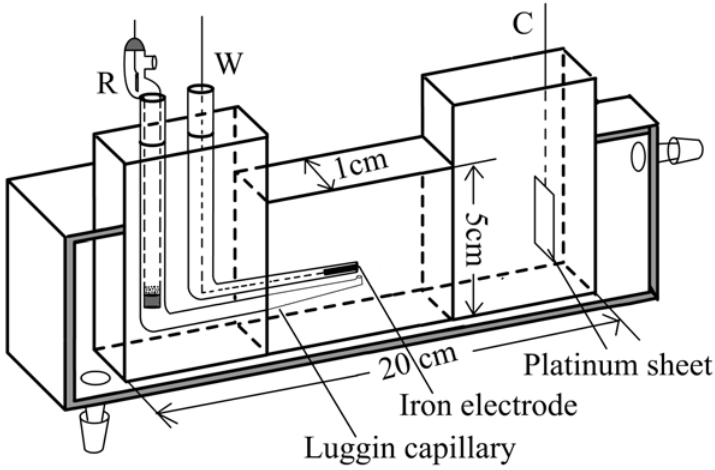
Figure 1. Schematic diagram of the electrochemical cell. R, reference electrode; W, working electrode; C, counter